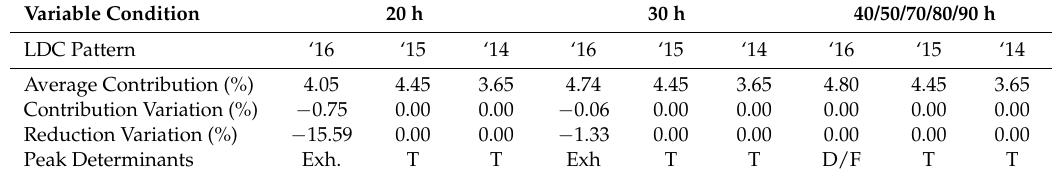
Table 7. Summary of sensitivity simulation results with maximum dispatch duration.